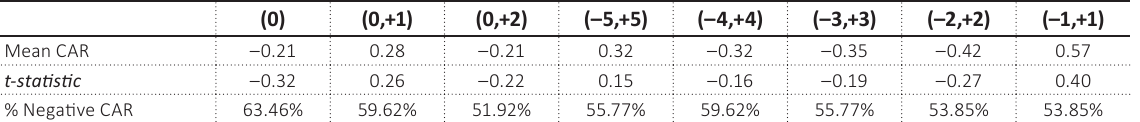
Table 4. Cumulative abnormal returns around rights issue announcements: Non-family